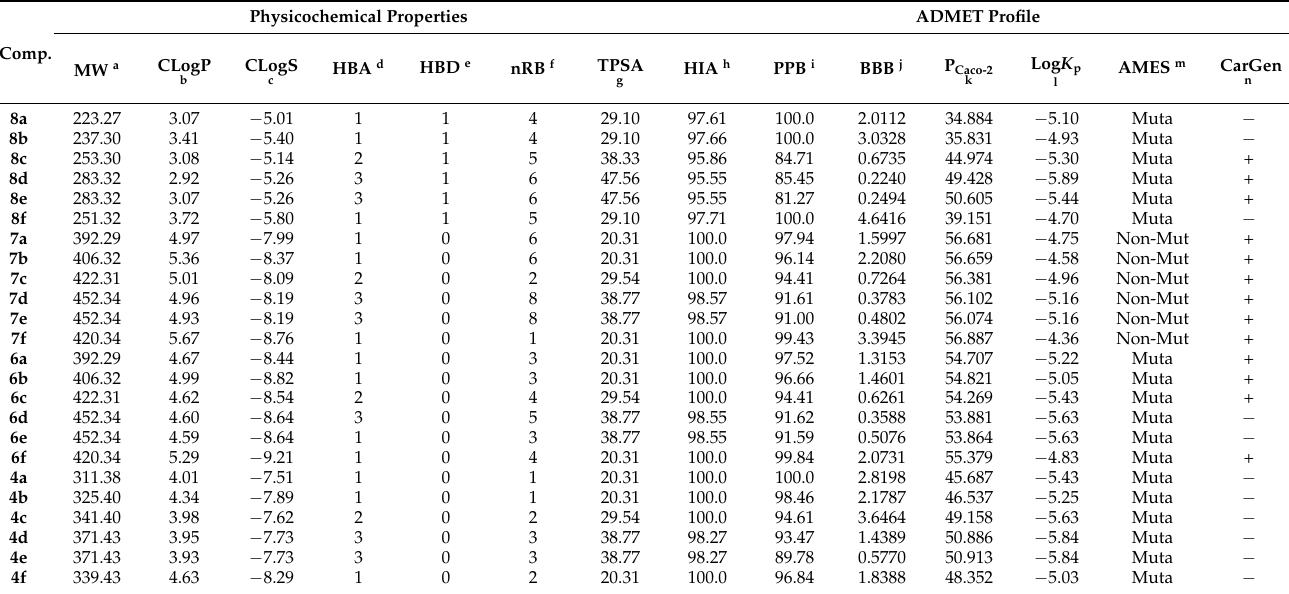
Table 1. Calculated parameters of Lipinski’s rule of five and ADMET profile for molecules 4 , 6 – 8 using the SwissADME and PreADME